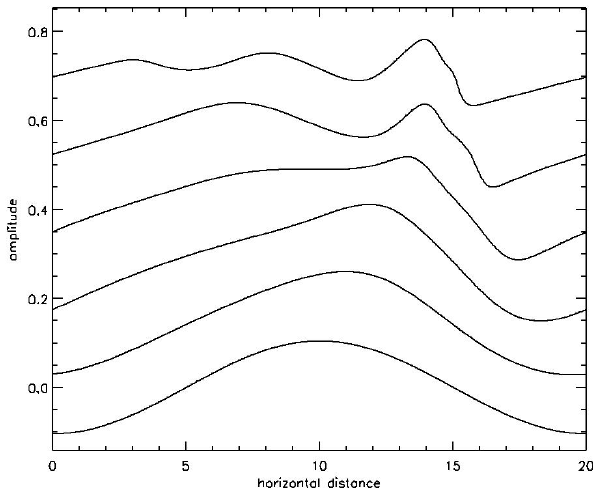
Fig. 11. Cuts taken at z =0 through the horizontal velocity field ob- tained from the deep domain initialized with a velocity duct. Note that 2 of these cuts are from panels (b) and (d) of Fig. 11 and the rest are from contours not shown. Times are 0, 8, 15, 23, 30,